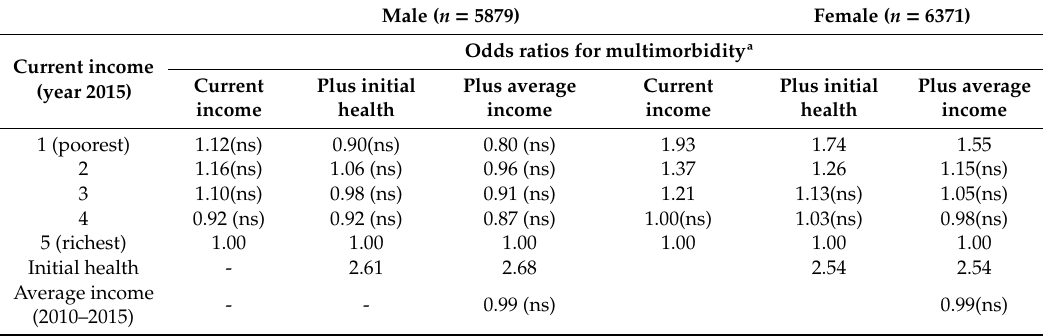
Table A1. Subgroup analysis for the e ff ect of a time dimension on the association between current income and multimorbidity.